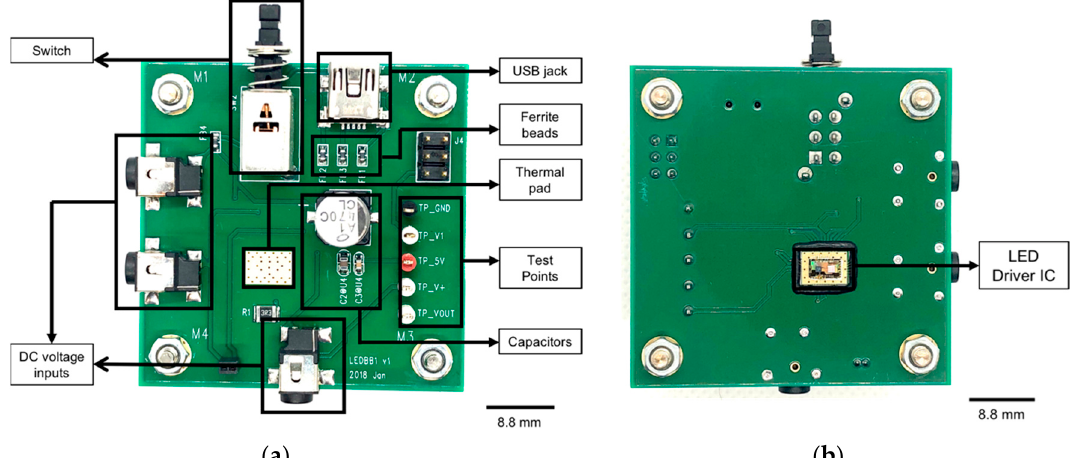
Figure 12. LED driver integrated circuit (IC) wire-bonded to the printed circuit board (PCB) evaluation board.